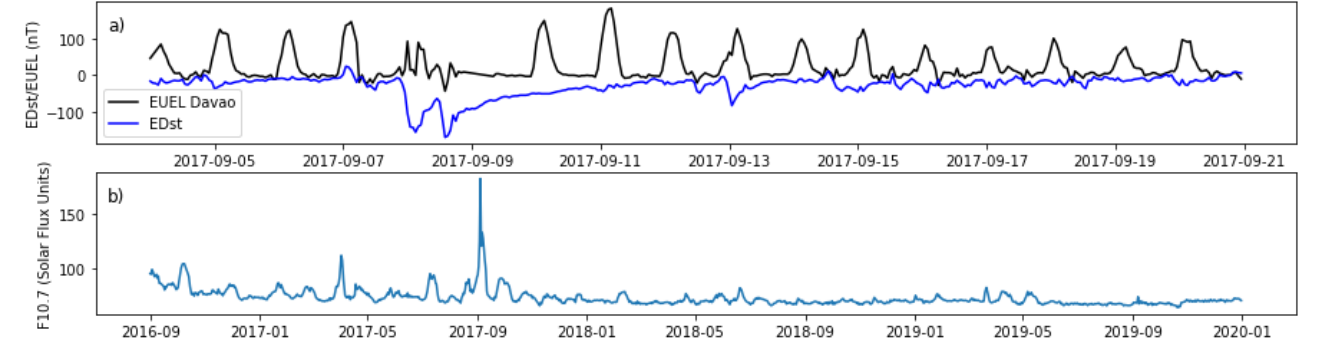
Figure 6. Example timeseries of hourly values of ( a ) EDst (blue) and EUEL (Davao, Philippines) (black), and ( b ) daily values of F10.7 solar radio flux. Note the different date ranges on the x-axes.